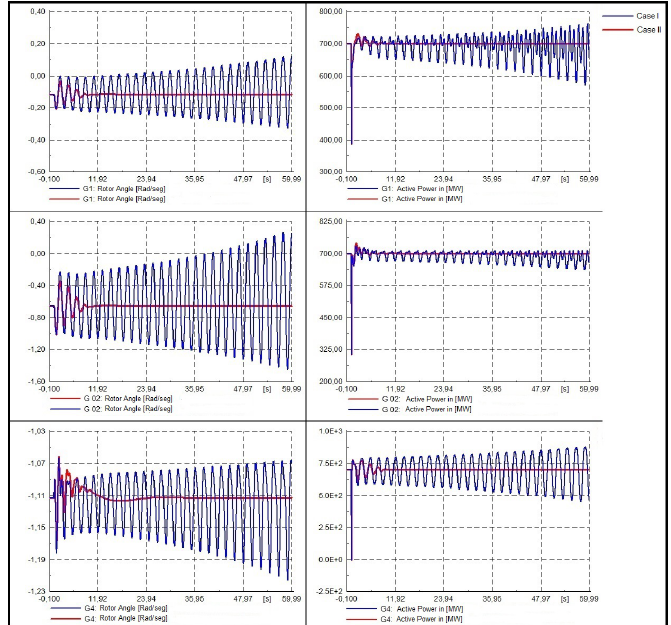
Figure 18. Rotor angle and active power [MW]-three phase fault at C1 line